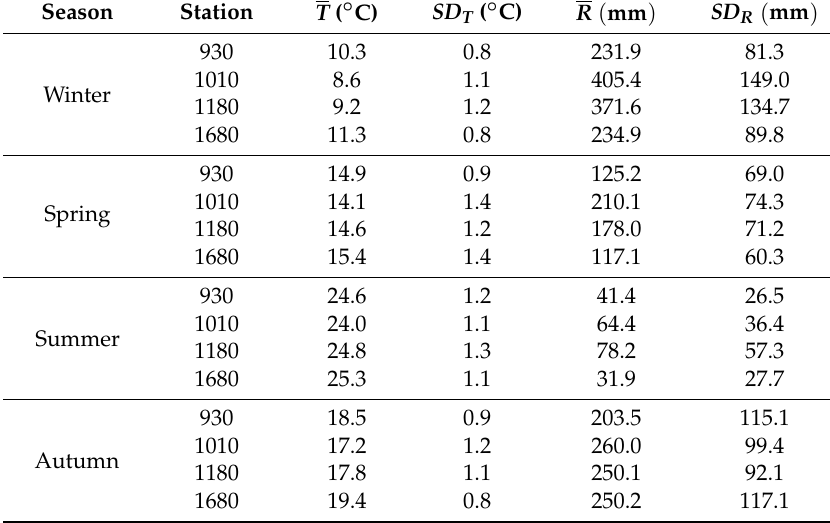
Table 2. Main statistics of temperature and rainfall for the reference period 1961–1990. ( T : mean daily temperature, SD T : standard deviation of temperature, R : cumulated rainfall, SD R : standard deviation of rainfall.)